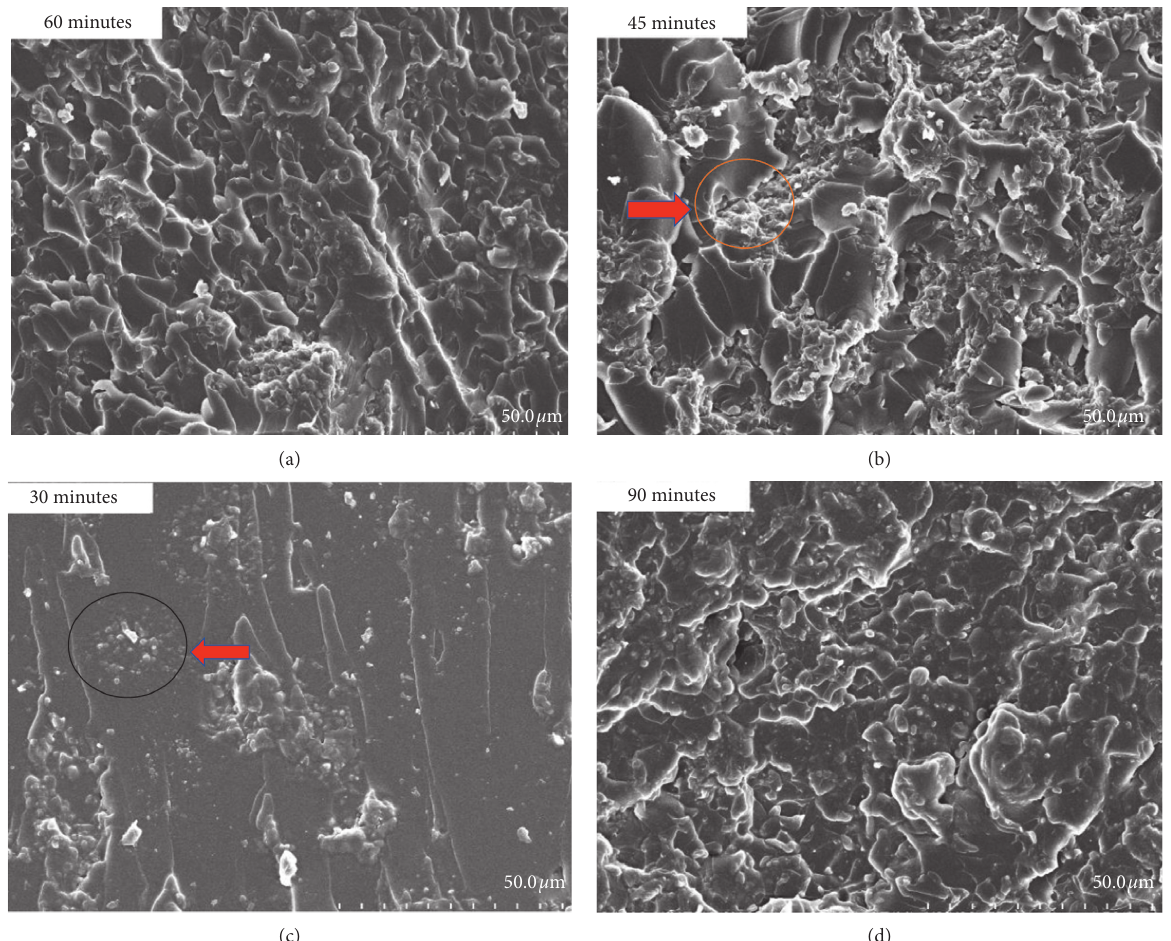
Figure 7: FE-SEM of epoxy Epikote 240/nanoclay I.30E nanocomposite materials.